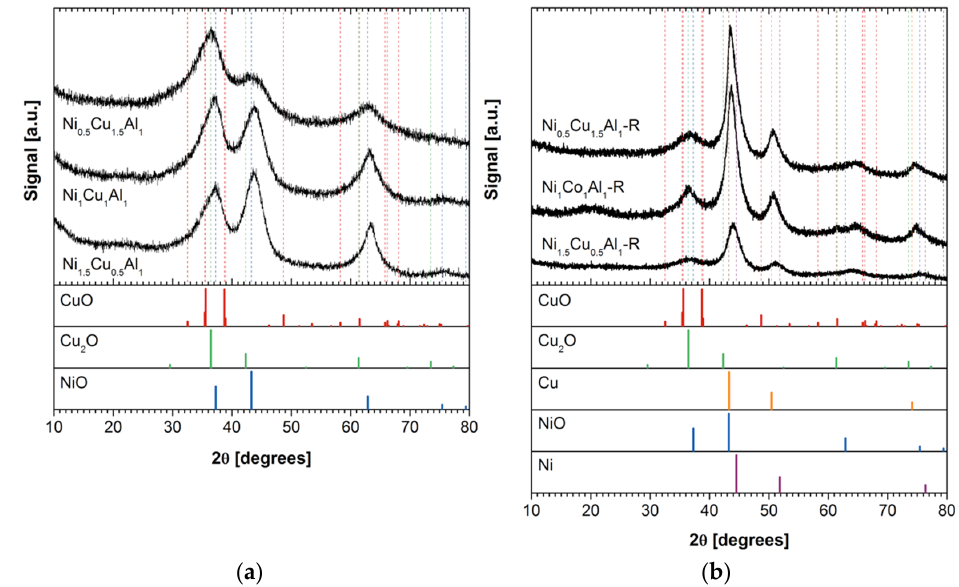
Figure 4. XRD patterns: ( a ) LDH precursors calcined at 673 K for 4 h; ( b ) reduced catalysts. The reducibility of the calcined materials was studied by temperature-programmed reduction under 10% hydrogen in argon (H 2 -TPR) from 375 to 1075 K (Figure 5). Two well- differentiated peaks of hydrogen consumption were observed. The peak at the lowest temperature corresponded to the reduction of highly dispersed particles of copper oxides